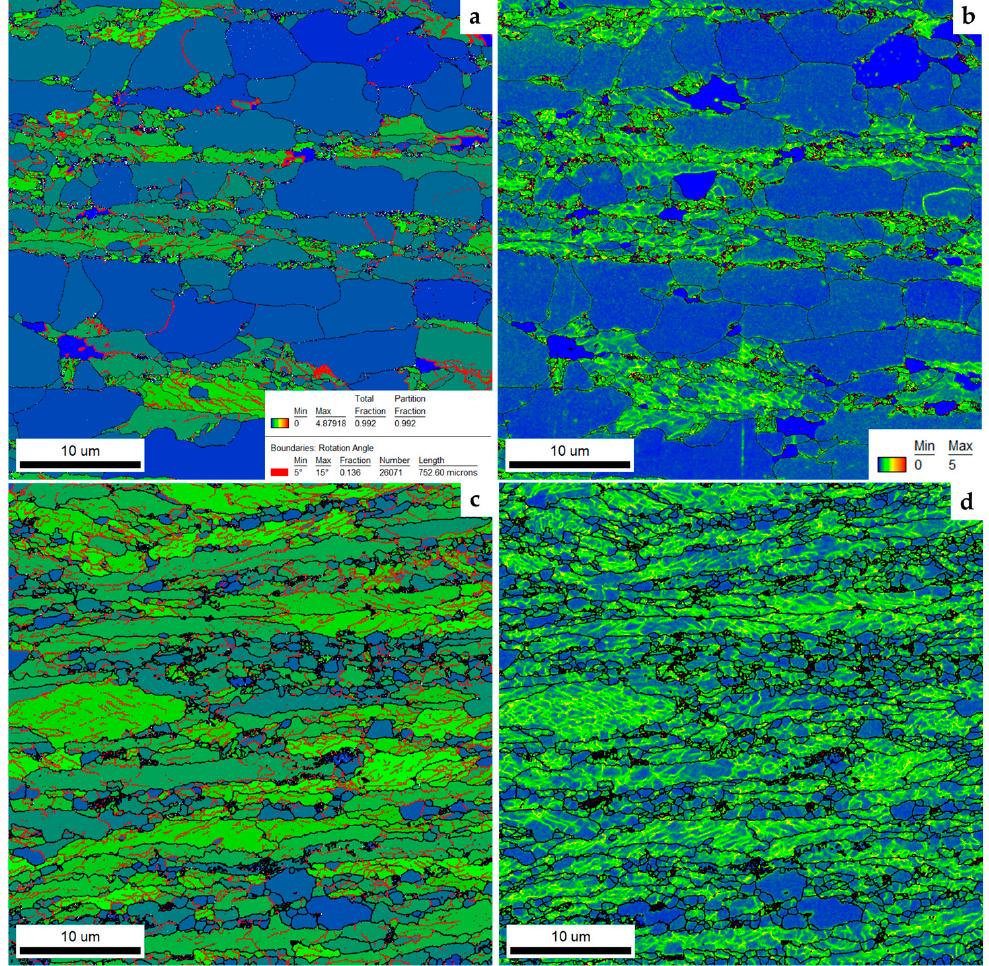
Figure 9. The grain average misorientation (GAM) map for the ( a ) CH and ( c ) the UFH sample including the low angle grain boundaries (LAGBs; 5–15°, red lines). Recrystallization of ferrite is expected to result in lower grain average misorientations and appear in blue with no LAGBs. Recovered ferrite and martensite appear in green and LAGBs are included in the grains. Supplementary kernel average misorientation (KAM) maps for the ( b ) CH and ( d ) UFH show the local misorientation due to dislocations present in the lattice. Recrystallized ferrite appears with much lower dislocation density than recovered ferrite and martensite.